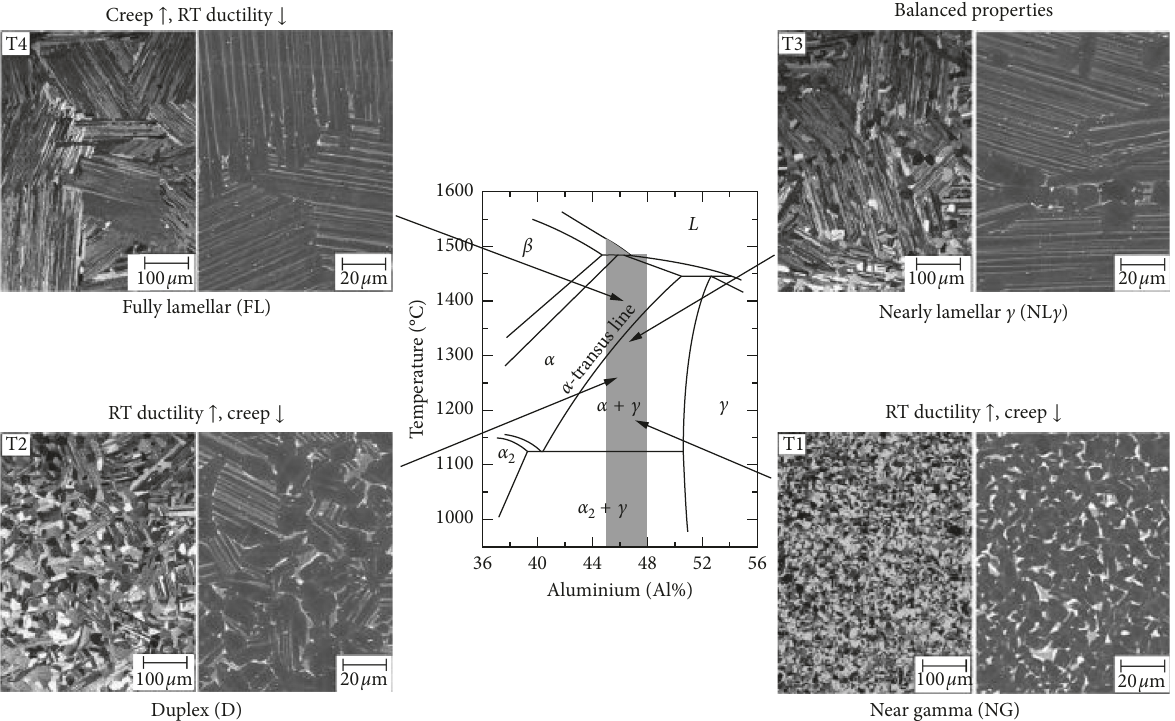
Figure 5: Midsection of the binary Ti-Al phase diagram and representative microstructures obtained through heat treatments within the α - and ( α + c ) -phase field. Note that the left half of the microstructural image represents a light-optical microscope (OM) image, whereas the right half is an SEM image taken in BSE mode, i.e., c -TiAl appears dark, whereas α ) ⟶ near gamma (NG) microstructure; between T the eutectoid temperature ( T eu microstructure. The volume fraction of lamellar grains depends on the heat treatment temperature relative to T nearly lamellar (NL) microstructure. The designation NL c stands for a NL microstructure exhibiting a defined volume fraction of globular c -grains, above T ⟶ FL microstructure (adopted from α